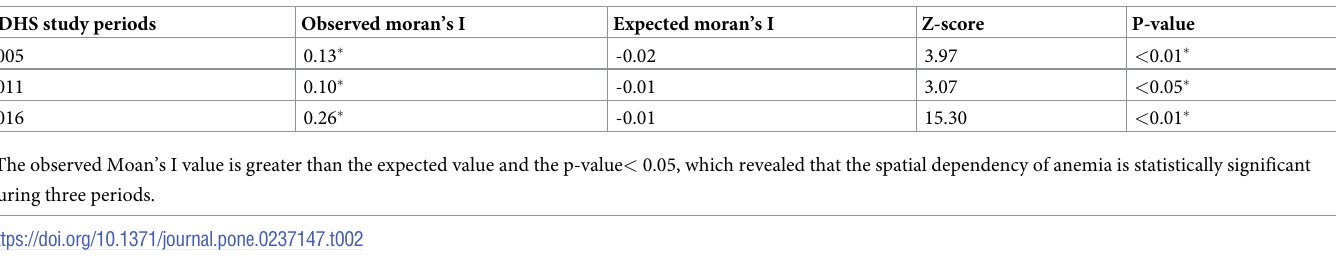
Table 2. Spatial autocorrelation analysis of anemia among lactating mothers in Ethiopia, 2005, 2011, and